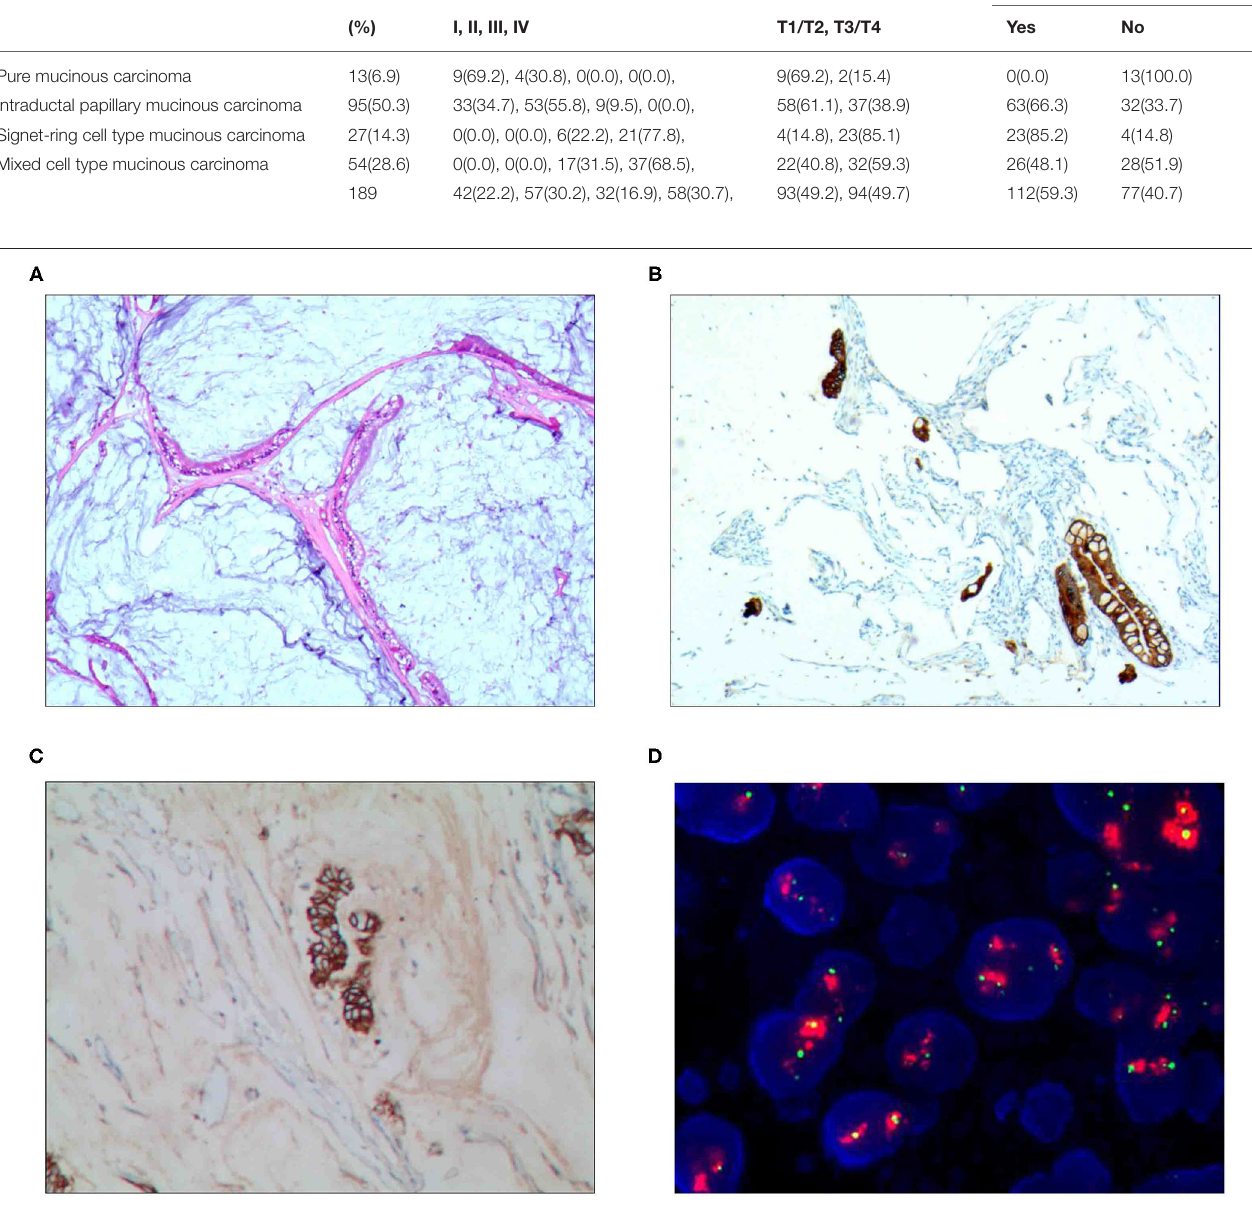
TABLE 2 | Comparison for macroscopic type, histological stages, and lymph node metastasis of gastric adenocarcinoma with mucinous differentiation. Histological type